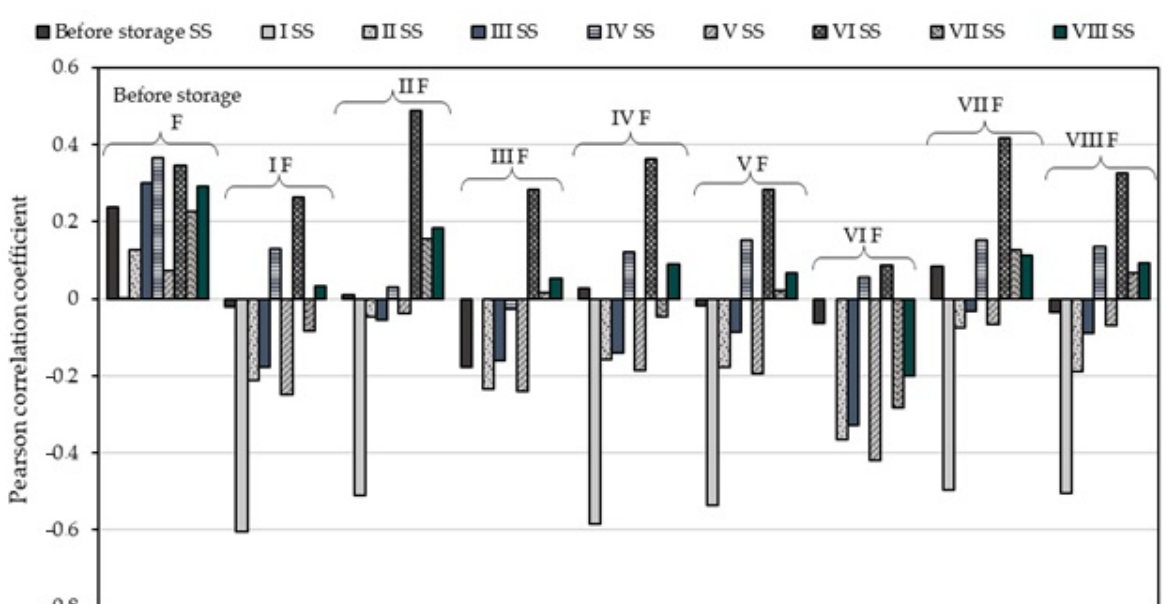
Figure 3. Content of soluble solids (SS) and firmness (F) of apples, Pearson’s correlation coefficients. 0 < |r| ≤ 0.3 is a weak correlation; 0.3 < |r| ≤ 0.7 is a moderate correlation; 0.7 < |r| ≤ 1 is a strong correlation [59].